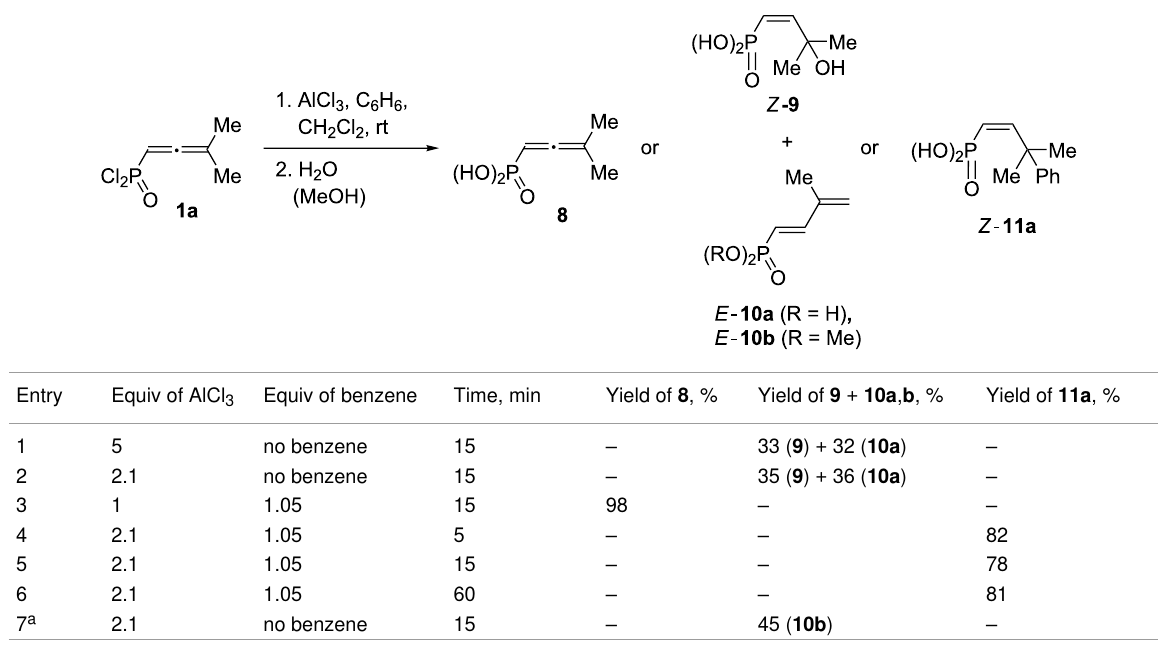
Table 2: AlCl 3 -promoted reactions of allene 1a at room temperature with/without benzene at various conditions.